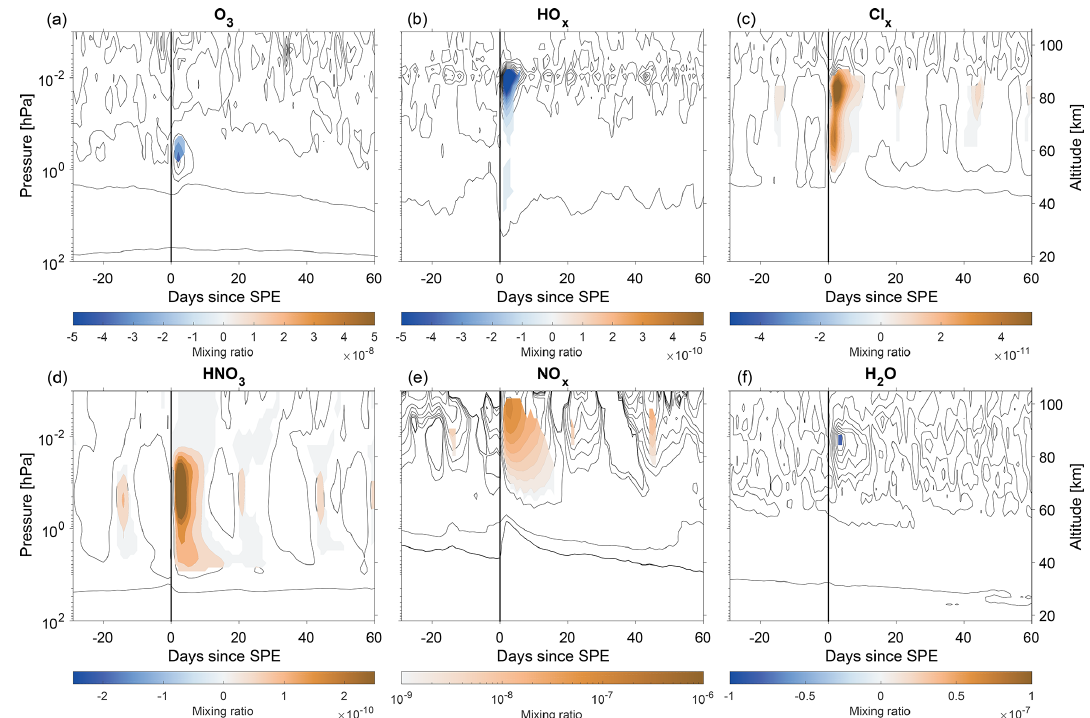
Figure 6. Area-weighted northern polar cap averages (latitude > 60 ◦ N) of composite means of (cid:100) WD – (cid:100) REF (see Fig. 4). The x axis shows the number of days before and after the event (day 0, solid black line) and the y axis pressure levels in the model (hPa, a, d ) and approximate altitude (km, c, f ). Note that the color scale for NO x panel is logarithmic, and all contours shown in that panel indicate positive